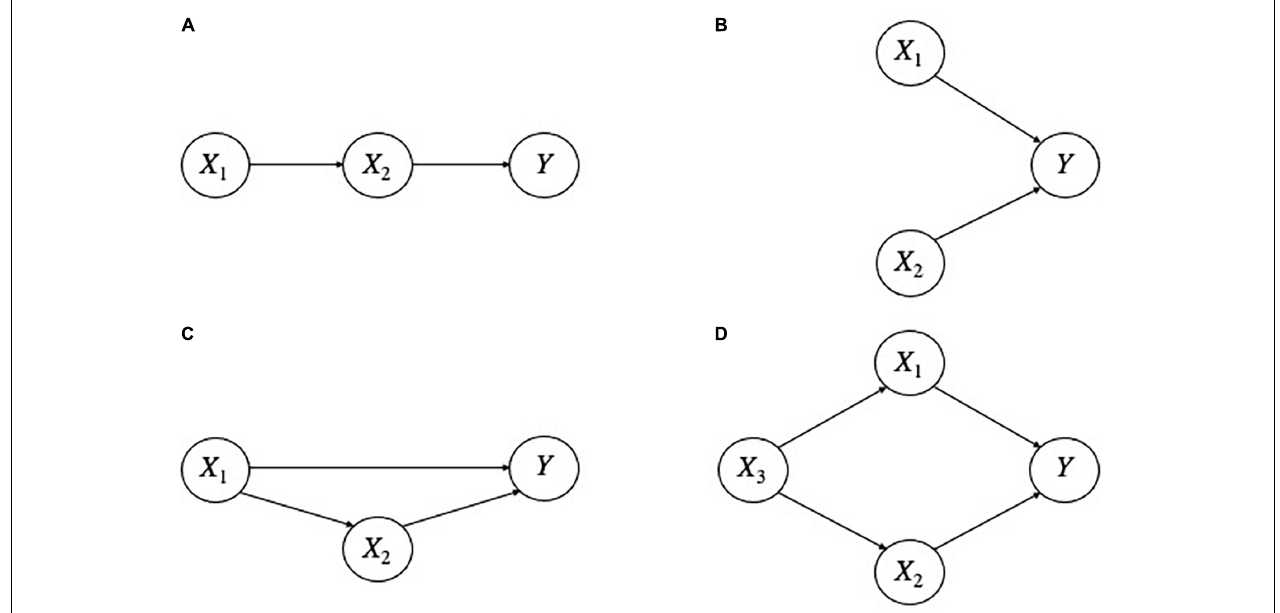
FIGURE 3 | Different inter-explanatory relationships. Letters at the head of an arrow denote phenomena to be explained; those at the tail, factors that do the explaining. Thus, X1 explains X2 and X2 explains Y in (A) ; X1 and X2 independently explain Y in (B) . X1 explains both X2 and Y , and X2 also explains Y in (C) ; X3 explains both X1 and X2 , which in turn each explain Y in (D)